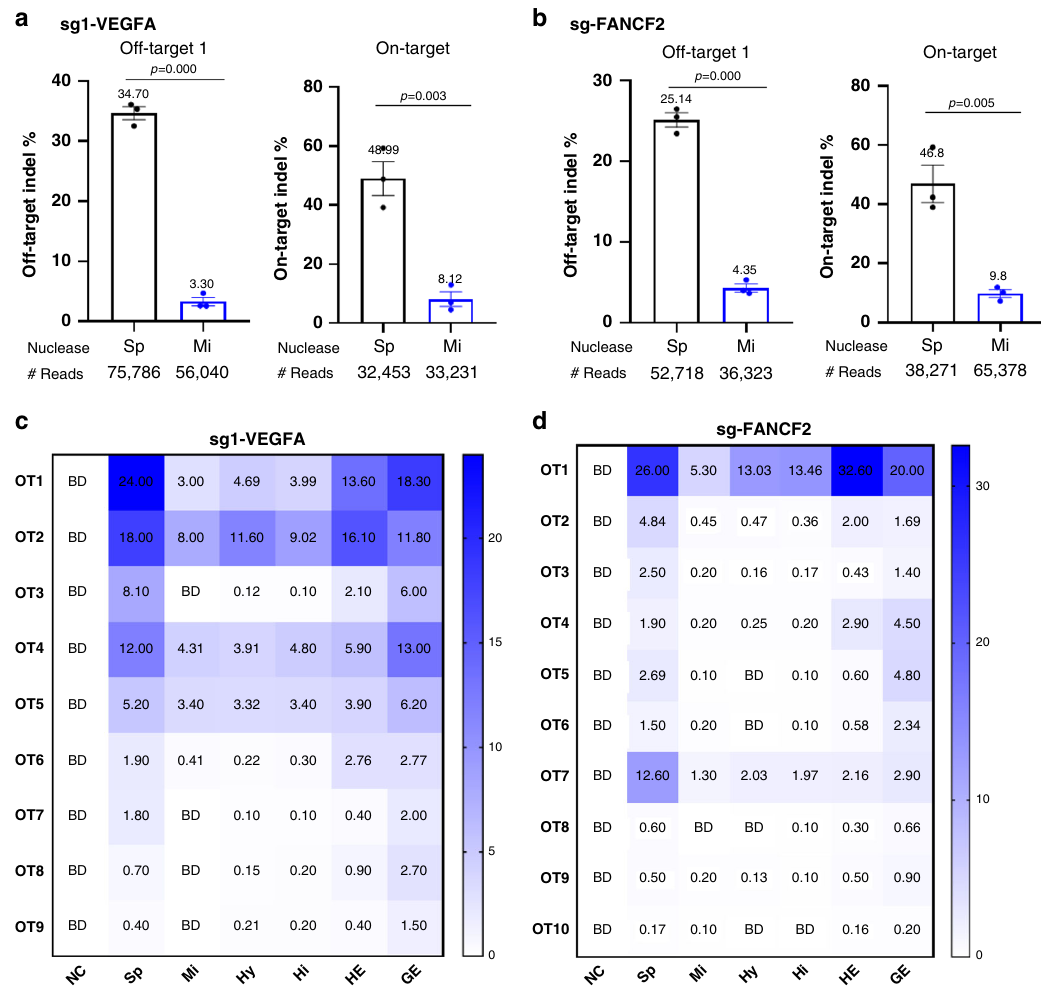
Fig. 3 MiCas9 reduces off-target indel rates. a Off-target and on-target indel rates associated with sg1-VEGFA by spCas9 and miCas9 pDNAs. b Off- target and on-target indel rates associated with sg-FANCF2 by spCas9 and miCas9 pDNAs. c Indel rates at Guide-seq predicted potential off-target loci associated with sg1-VEGFA by pDNAs of different nucleases. d Indel rates at Guide-seq predicted potential off-target loci associated with sg-FANCF2 by pDNAs of different nucleases. Sp: spCas9, Mi: miCas9, Hy: hypaCas9, Hi: HiFiCas9, HE: Cas9-HE, GE: Cas9-GE, NC: negative control with non-speci fi